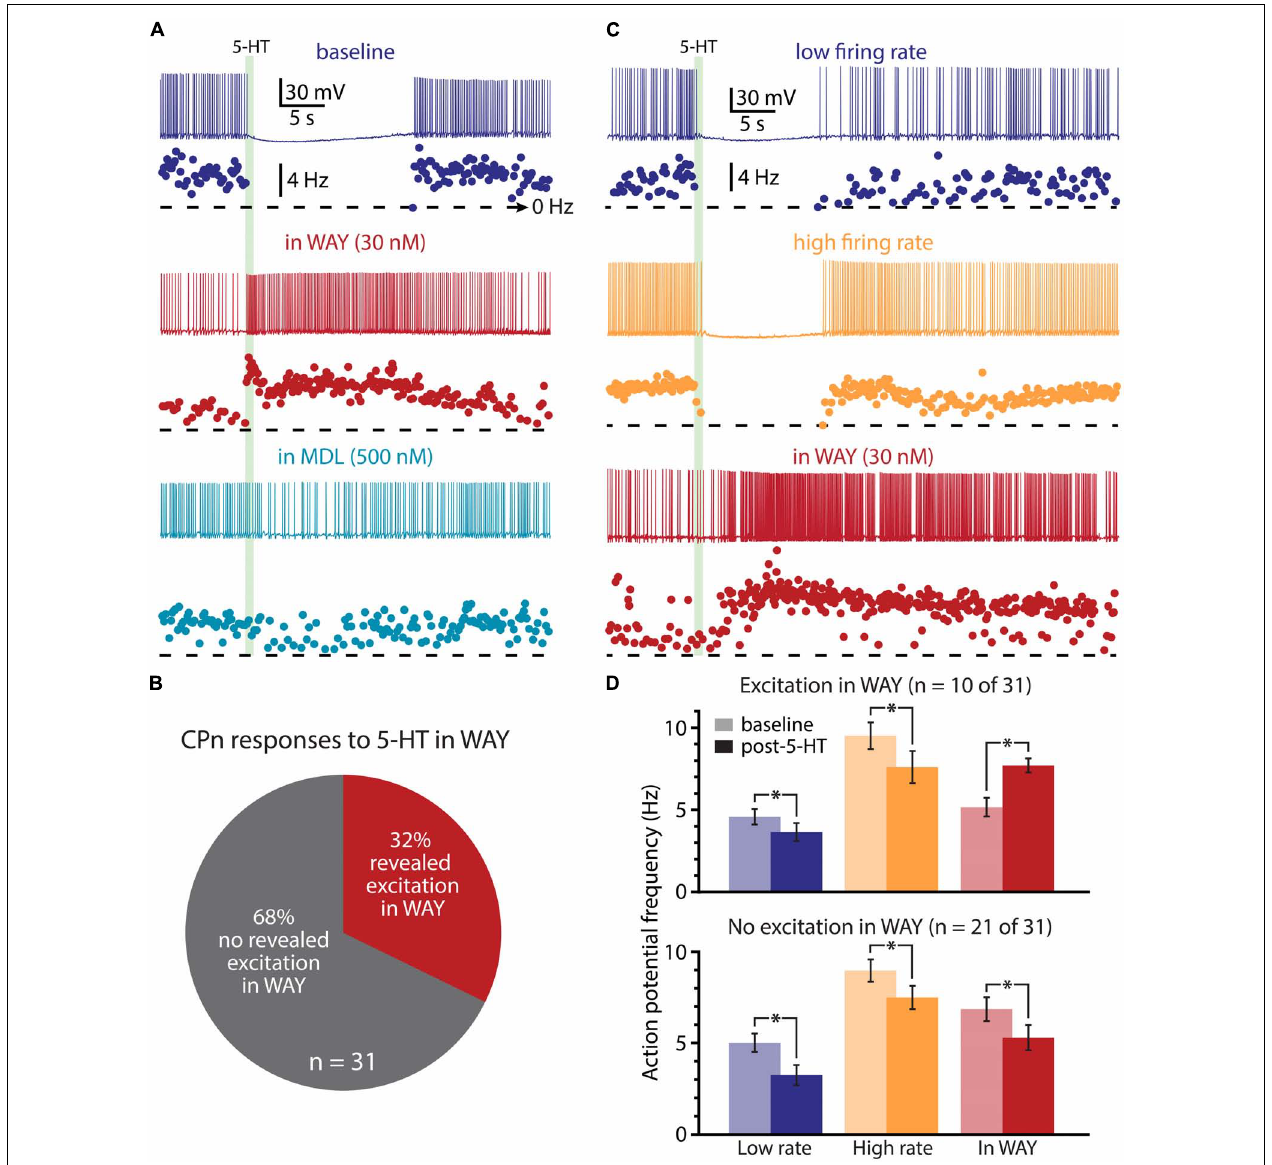
FIGURE 9 |A subpopulation of CPn neurons exhibit 2A-mediated excitation after blockade of 1A receptors. (A) Responses of a CPn L5PN to 5-HT delivered in baseline conditions (top; dark blue), after blockade of 1A receptors byWAY 100635 (WAY; middle; red), and after additional application of the 2A antagonist MDL 11939 (MDL; bottom; light blue). Plots beneath each trace show ISF over time.The timing of 5-HT application is indicated by the green bar. (B) Proportions of CPn neurons exhibiting excitatory responses to 5-HT (red) or no response to 5-HT (gray) in the presence ofWAY.